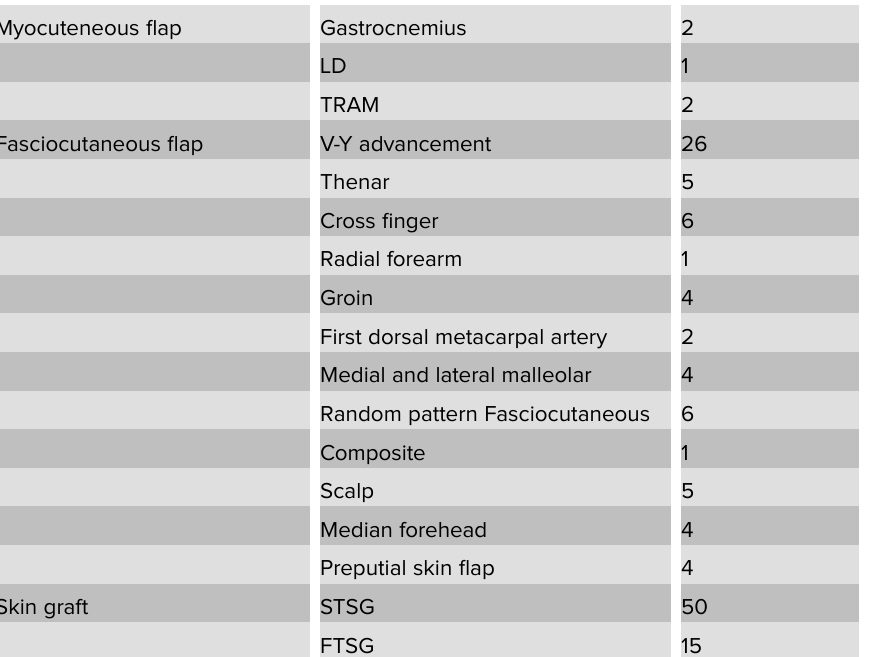
Table 3: Types of flap and graft